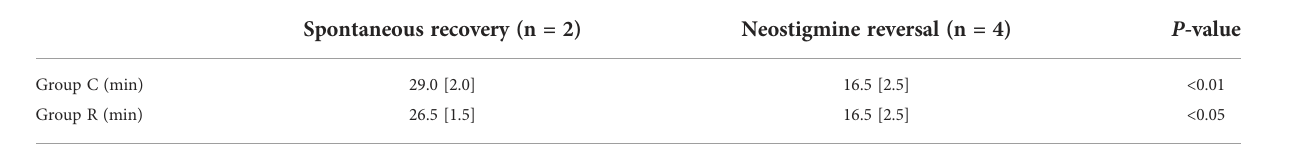
TABLE 1 Recovery time to 50% EMG